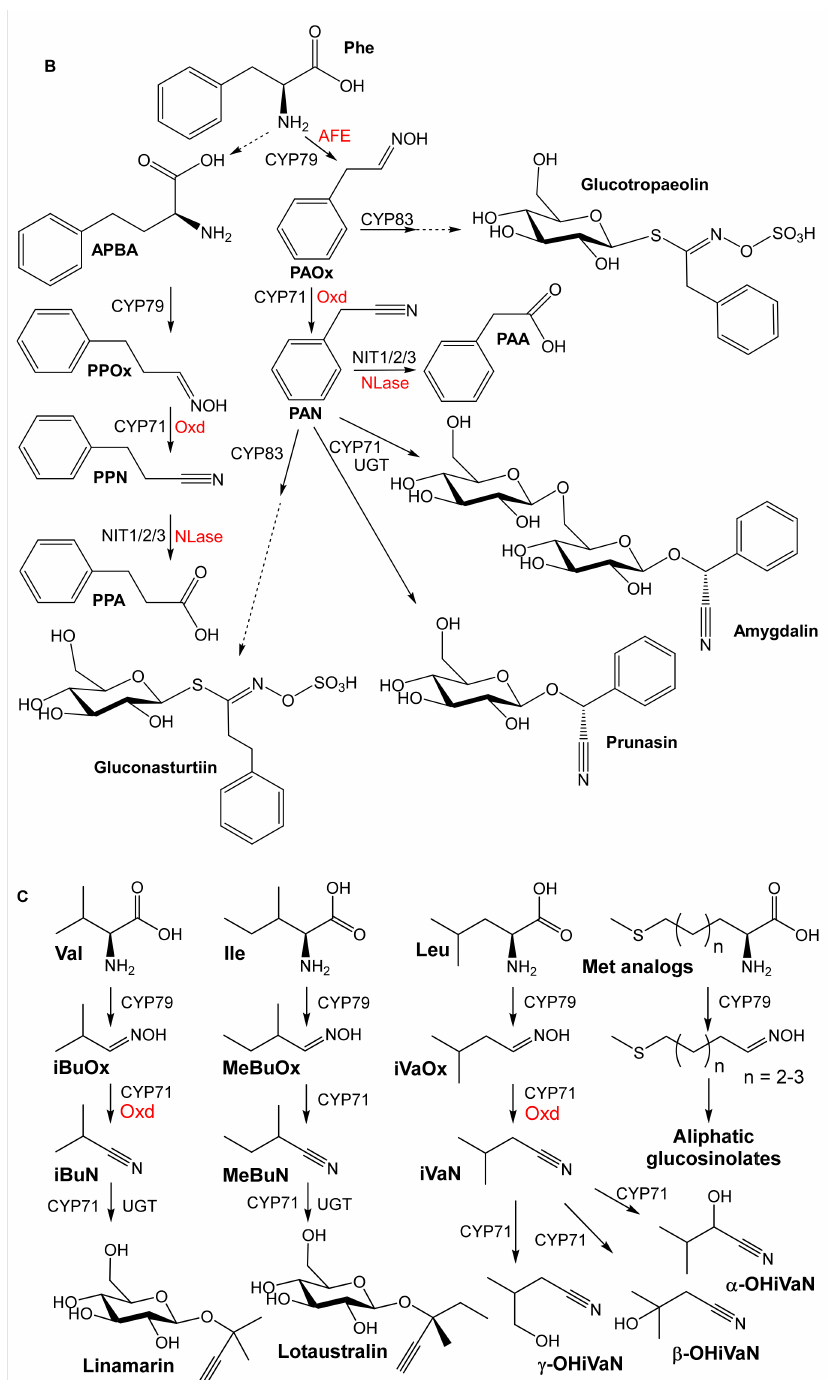
Figure 3. Plant and bacterial metabolism of ( A ) indole-3-acetaldoxime (IAOx), ( B ) pheny- lacetaldoxime (PAOx), 3-phenylpropionaldoxime (PPOx), ( C ) isobutyraldoxime (iBuOx), 2- methylbutyraldoxime (MeBuOx), isovaleraldoxime (3-methylbutyraldoxime; iVaOx), and methionine analogs (according to [1,3,27], modified). Plant and bacterial enzymes are shown in black and red, respectively. The hydroxy derivatives of iVaN are transformed to various glucosides (not shown). AFE, aldoxime-forming enzymes; APBA, 2-amino-4-phenylbutyric acid; CYP, cytochrome P450 (CYP71, CYP79, and CYP83 family); IAN, indole-3-acetonitrile; IAA, indole-3-acetic acid; iBuN, isobutyronitrile; iVaN, isovaleronitrile; MeBuN, 2-methylbutyronitrile; NIT1/2/3, plant nitrilases of NIT1, NIT2, and NIT3 type; NLase, nitrilase; PAA, phenylacetic acid; PAN, phenylacetonitrile; PPA, 3-phenylpropionic acid; PPN, 3-phenylpropionitrile; UGT, UDP-glucosyl